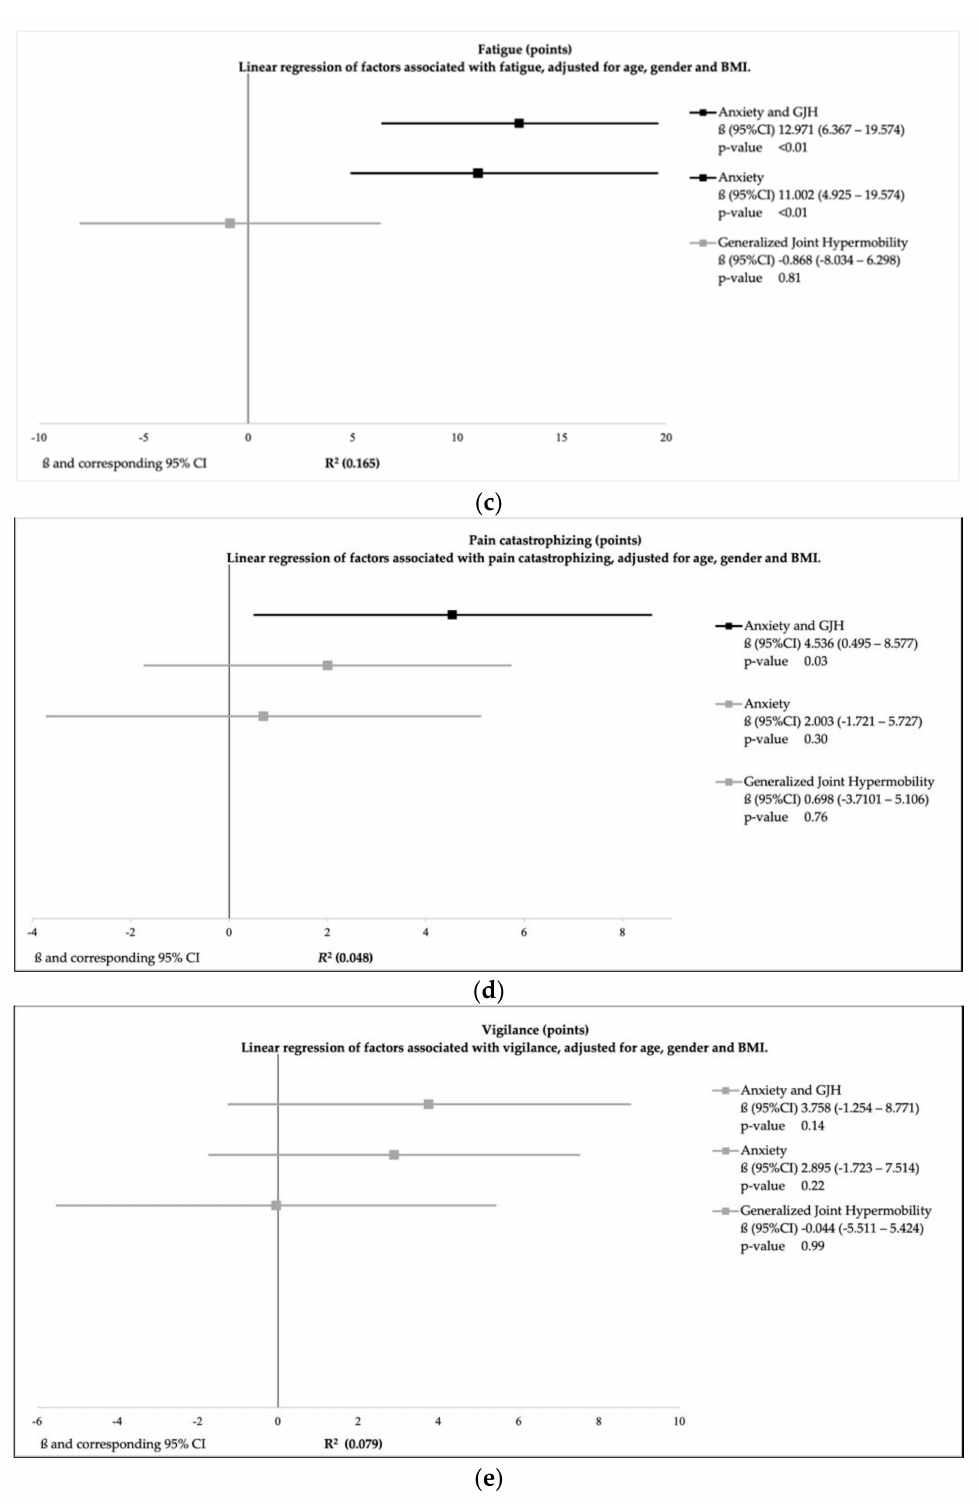
Figure 1. Linear regression models of physical and psychological factors adjusted for age, gender and BMI. Linear regression models of psychological factors adjusted for age, gender, and